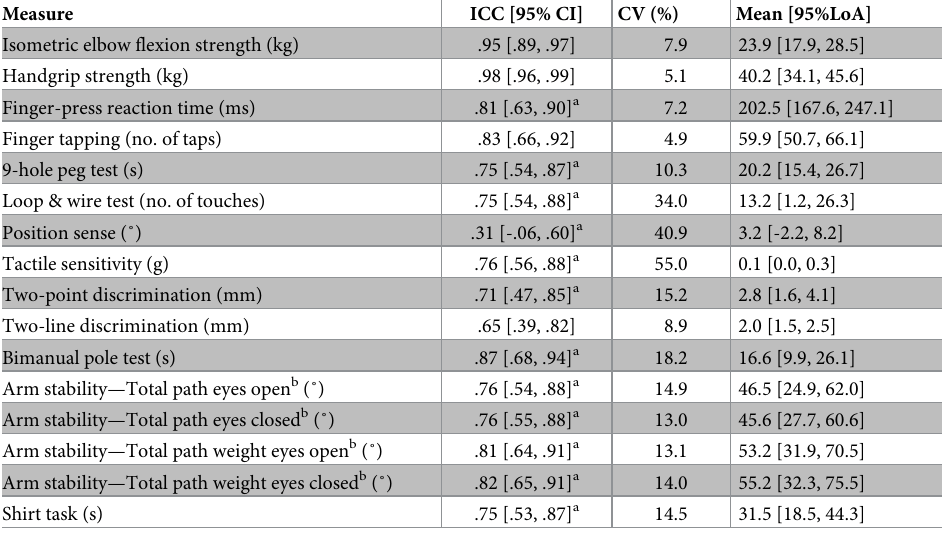
Table 4. Intra-class correlation coefficients, coefficients of variation and 95% limits of agreement for each test.